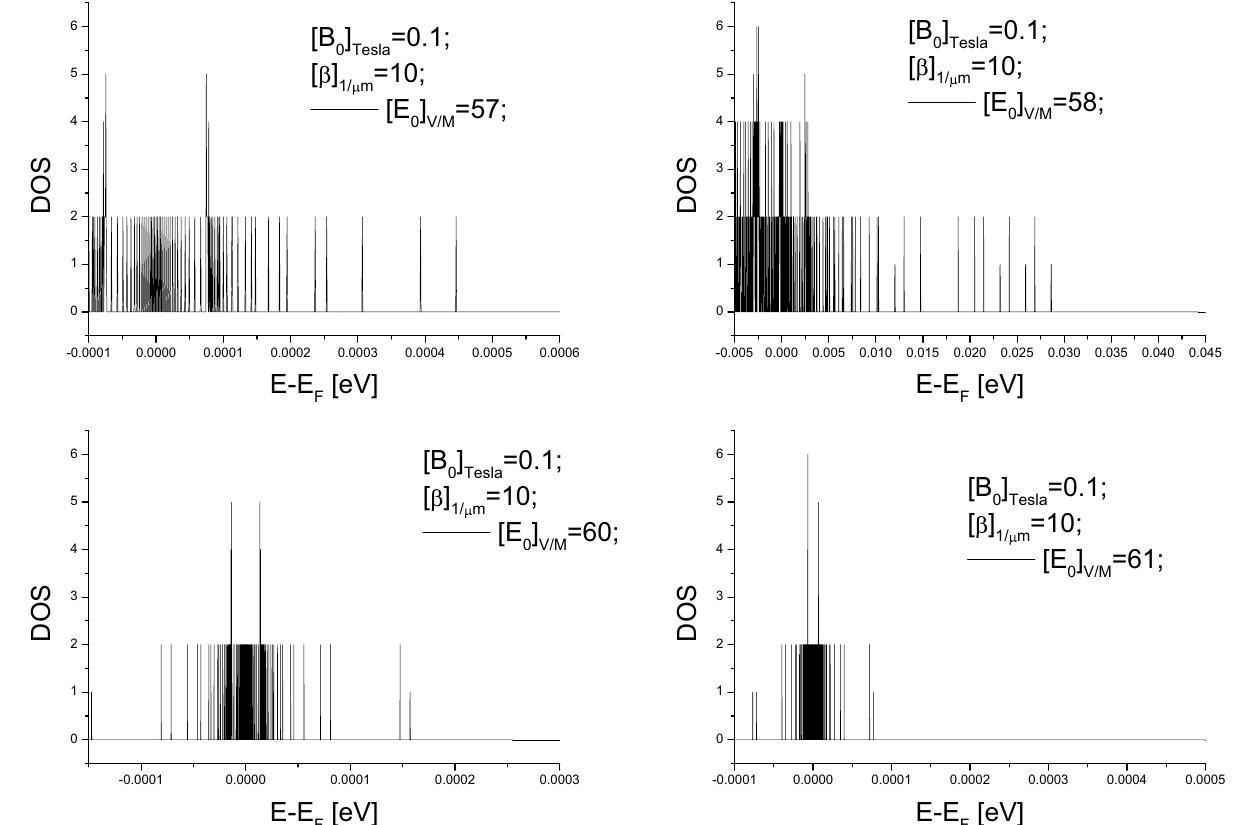
Figure 3. Example illustrating the dependence of the pseudogap width of DOS curve on controllable